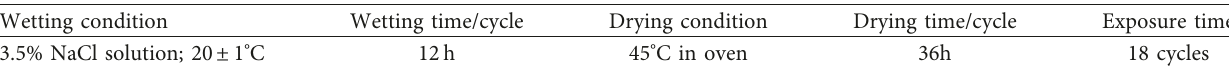
Table 2: Cyclic wetting-drying condition.